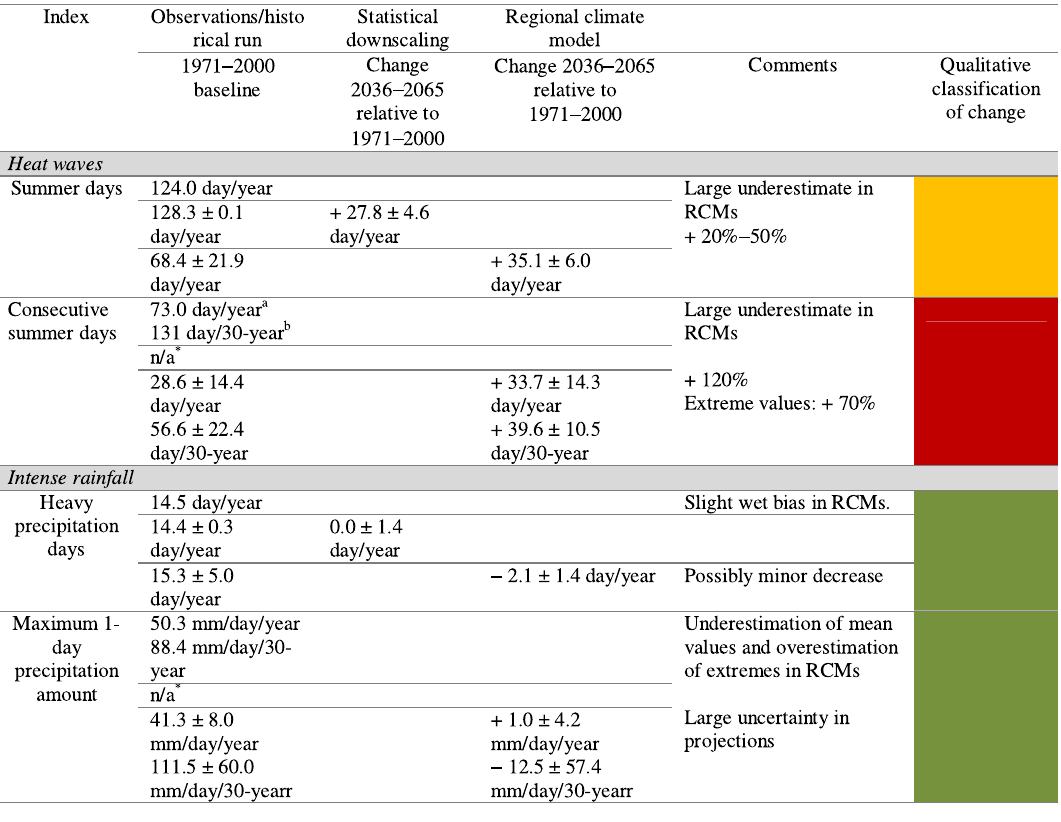
Table 4 Climate analysis summary, illustrated for the heat wave and intense rainfall hazards for the study area in Crete, Greece